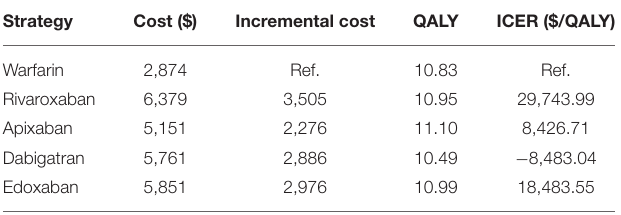
TABLE 3 | Fatality and utility used in base-case analysis.